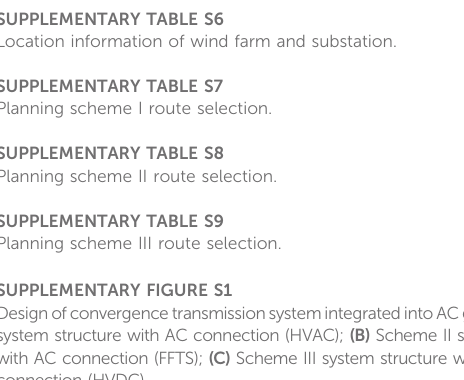
system structure with AC connection (HVAC); (B) Scheme II system structure with AC connection (FFTS); (C) Scheme III system structure with DC connection